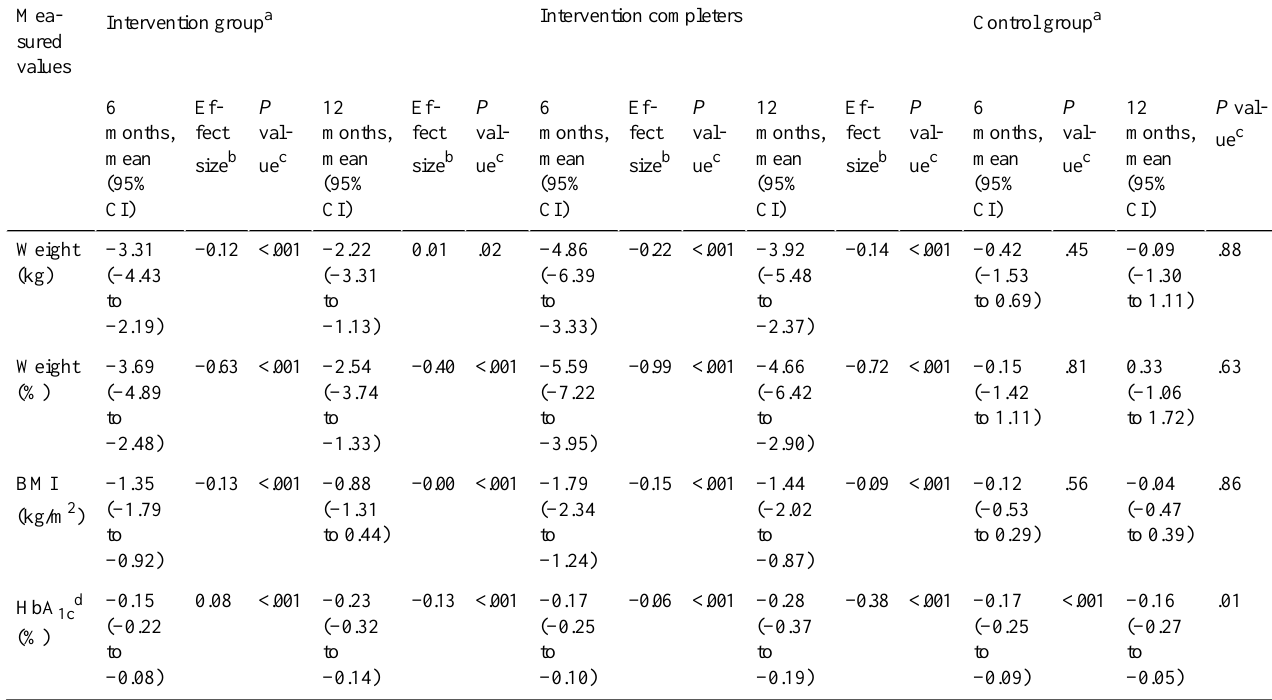
Table 2. Change in body weight and hemoglobin A 1c at 6 and 12 months by participant group (intervention, intervention completers, and control group).